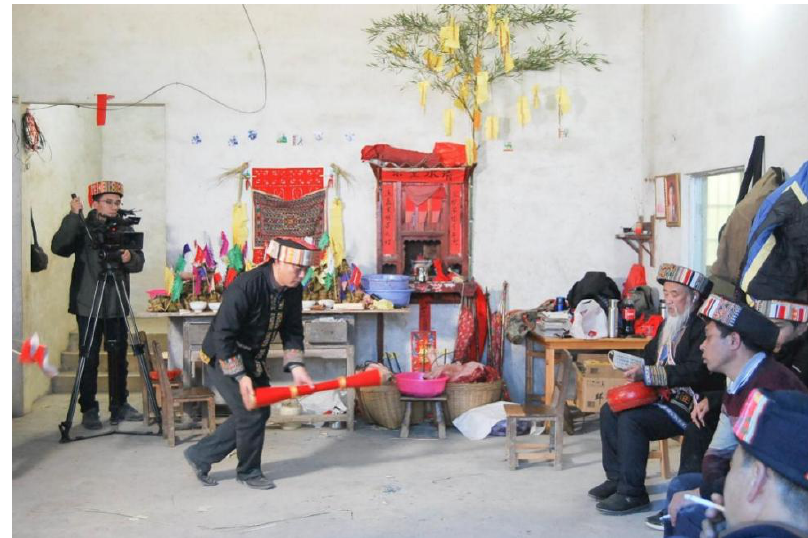
Figure 10. Master Zhao Guifu performing the long-drum dance